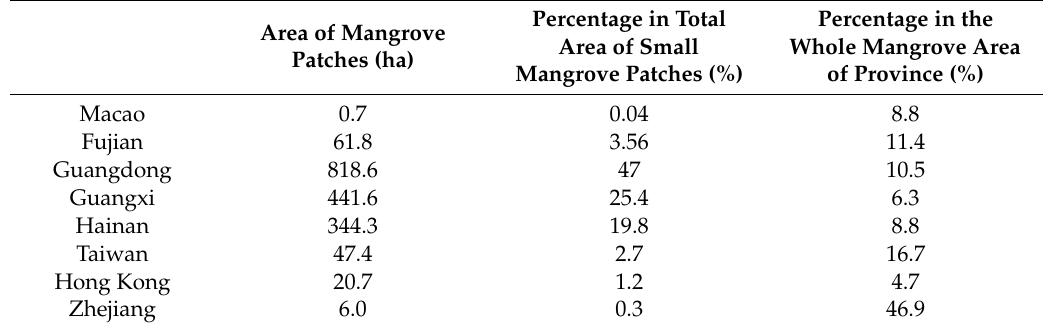
Table 6. The area of mangrove patches with size smaller than 1 ha in di ff erent regions. Area of Mangrove Patches (ha)